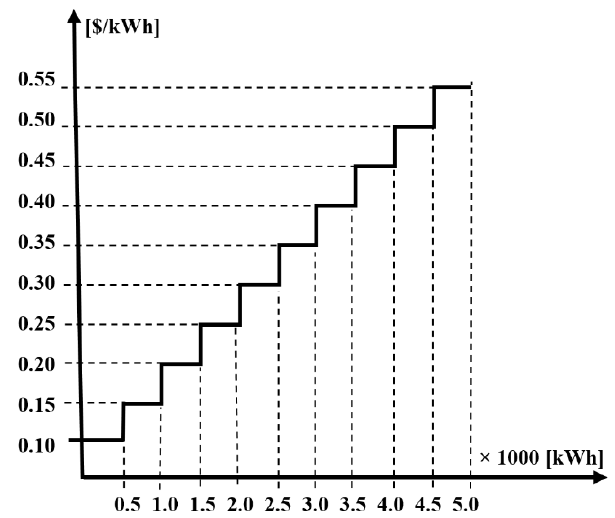
Figure 5. Piece-wise linear substation energy cost model.